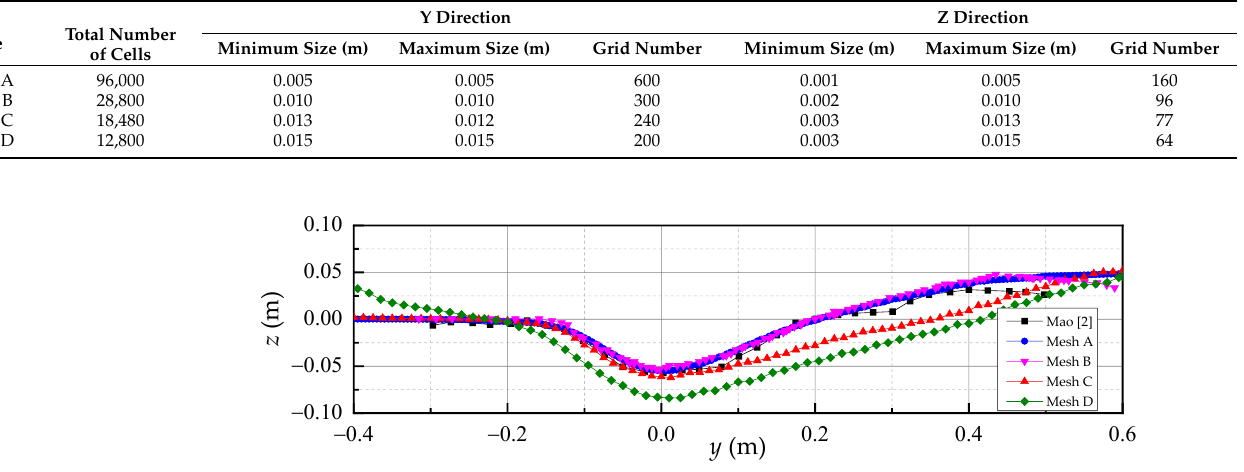
Figure 2. The numerical results of scour hole profile with different mesh levels ( t = 370 min).